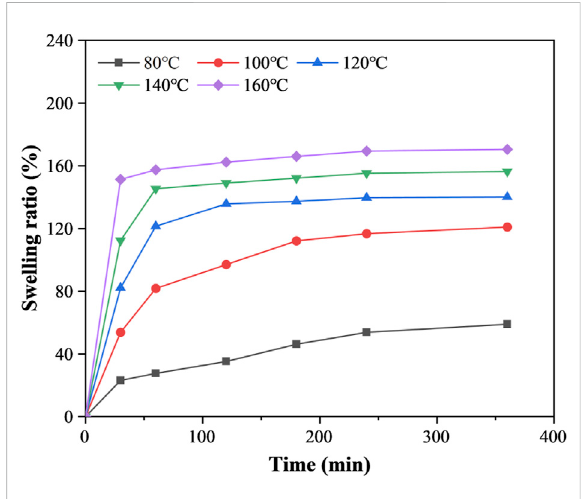
FIGURE 3 Swelling curves of CFRP in DMAC at different